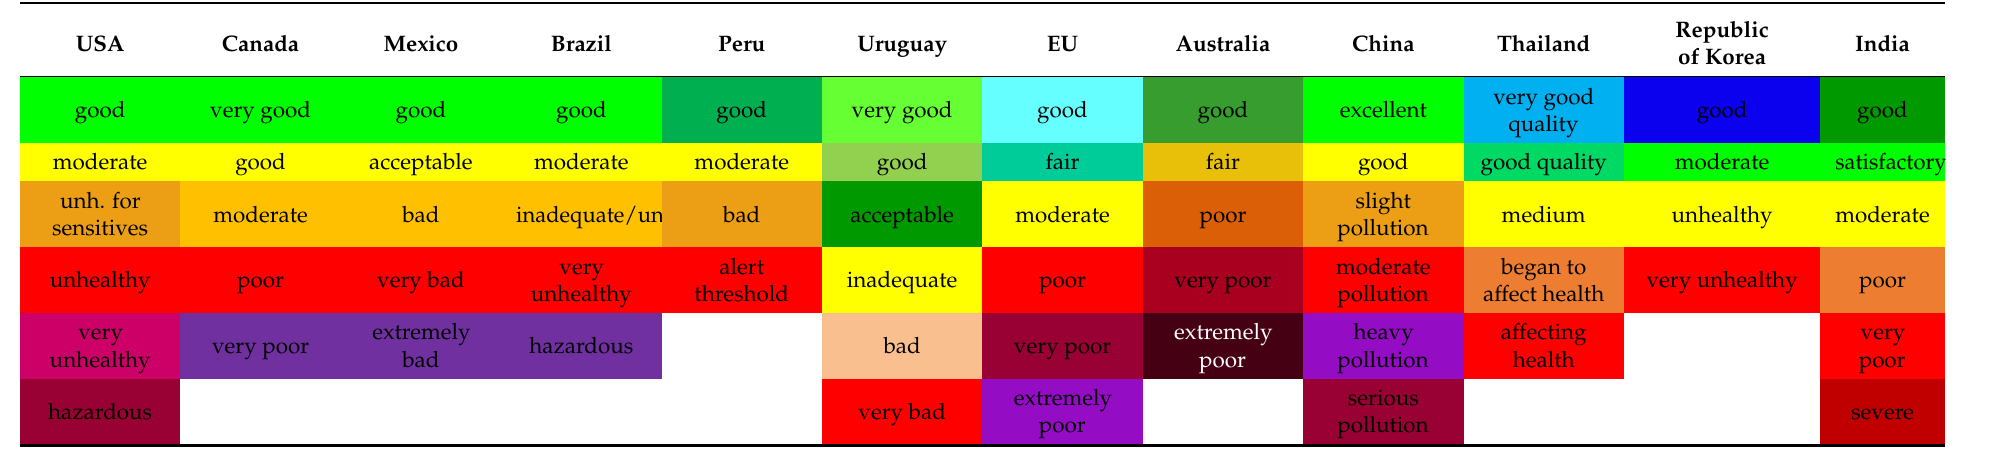
Table 2. AQI chromatic scales of the countries